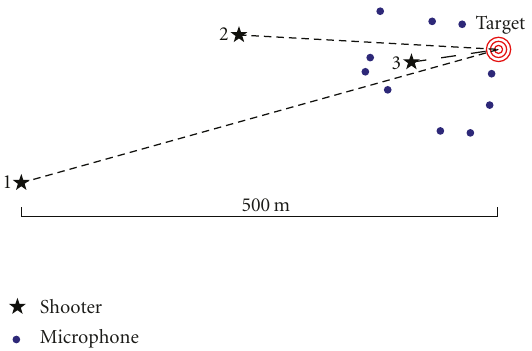
Figure 6: Scene of the shooter localization field trial. There are ten microphones, three shooter positions, and a common